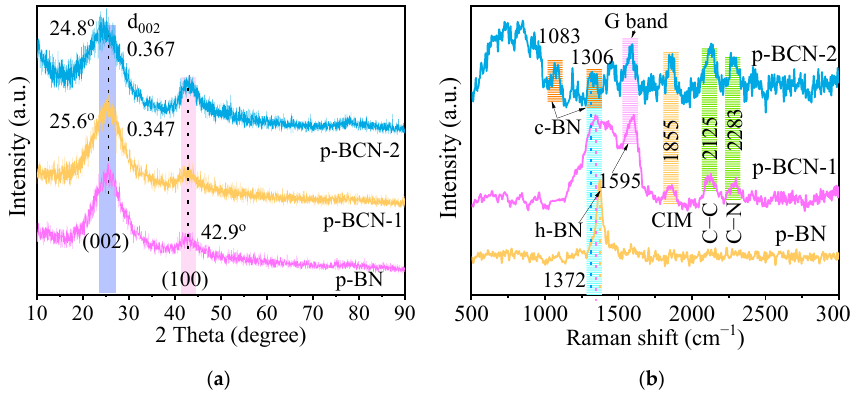
Figure 5. ( a ) Powder XRD patterns and ( b ) Raman spectra of p-BN, p-BCN-1, and p-BCN-2. The FTIR spectra of the p-BN, p-BCN-1, and p-BCN-2 samples are shown in Figure 6. The FTIR spectra confirmed that the intrinsic structure of the BN could not be formed in the p-BCN-1 until the calcination temperature of P1 reached 900 °C (Figure S7). Com- pared with that of the p-BN, the position of the in-plane stretching band of the p-BCN-1 shifted from 792 cm − 1 to 799 cm − 1 , while the out-of-plane B − N bending band shifted from 1380 cm − 1 to 1388 cm − 1 , respectively (Figure 6a). It may be the disruption of the B − N − B bond by the C element due to the conjugative effect of the C − N − B bond [33,41] which lead to a vibration at a higher wavenumber. The position of the in-plane B − N stretching band of the p-BN was consistent with that of the p-BCN-2, while the peak assigned to the out- of-plane B − N bending band at 792 cm − 1 for the p-BN blue shifted to 772 cm − 1 for the p- BCN-2 (Figure 6b). Due to the typical overlap of the C–N with the B–N bands around 1100~1300 cm − 1 , the peaks assigned to the C–N bonds faded. The FTIR spectra of the p- BCN-2 also exhibited absorption at 2850 cm − 1 and 2922 cm − 1 , which was assigned to C–H stretching vibrations [42], revealing the presence of an amorphous hydrogenated carbon ( α -C:H) in the p-BCN-2. Those results probably led to the vibration of the in-plane B − N stretching bands at a lower wavenumber [43]. The possible chemical composition of the